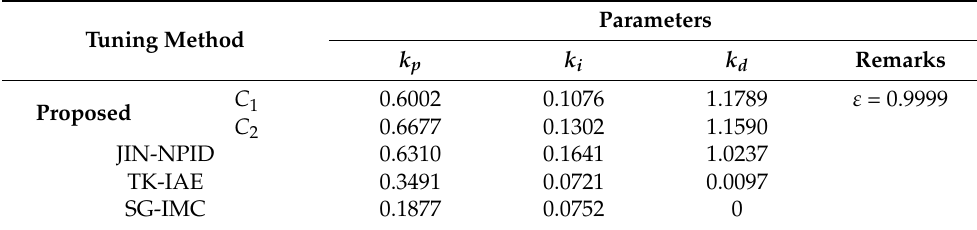
Table 7. PID controller tuning for process 3.